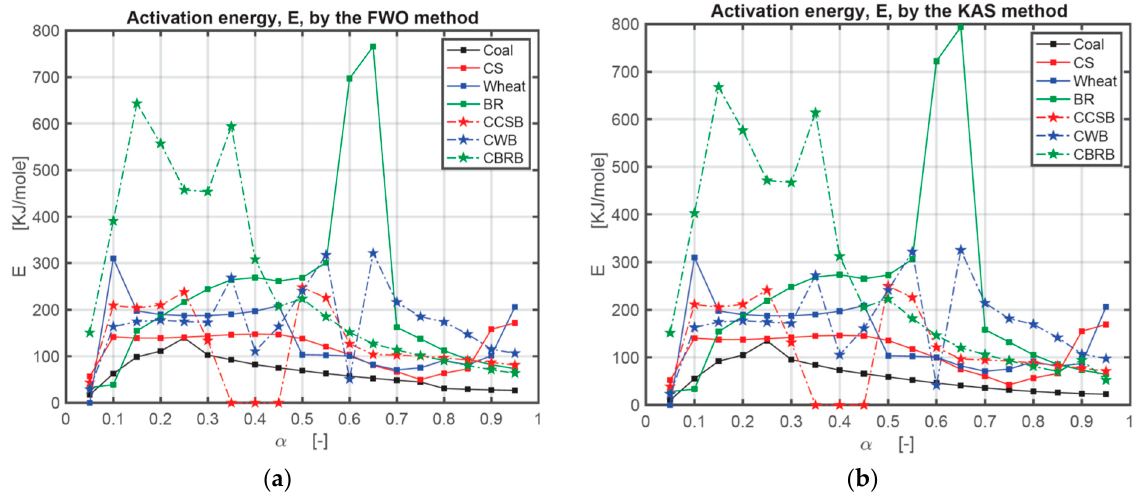
Figure 4. Comparison of activation energy ( E ) obtained with FWO and KAS method: ( a ) comparison of activation energy ( E ) obtained with FWO method; ( b ) comparison of activation energy ( E ) obtained with KAS method.